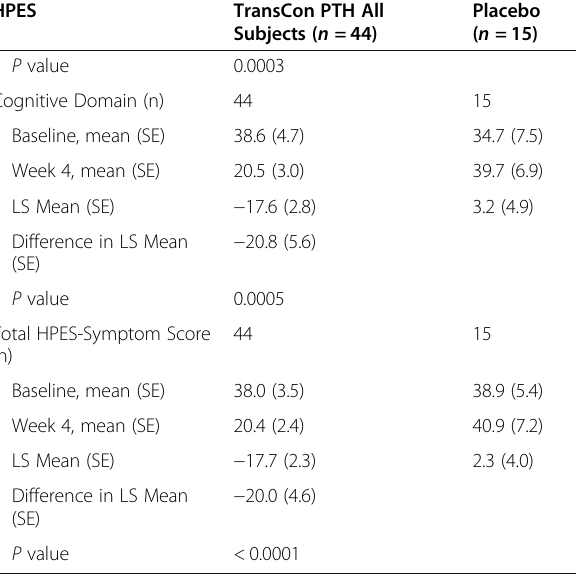
Table 10 Summary of HPES-Impact and HPES-Symptom Scales for TransCon PTH vs. placebo by ANCOVA (Full analysis set; N